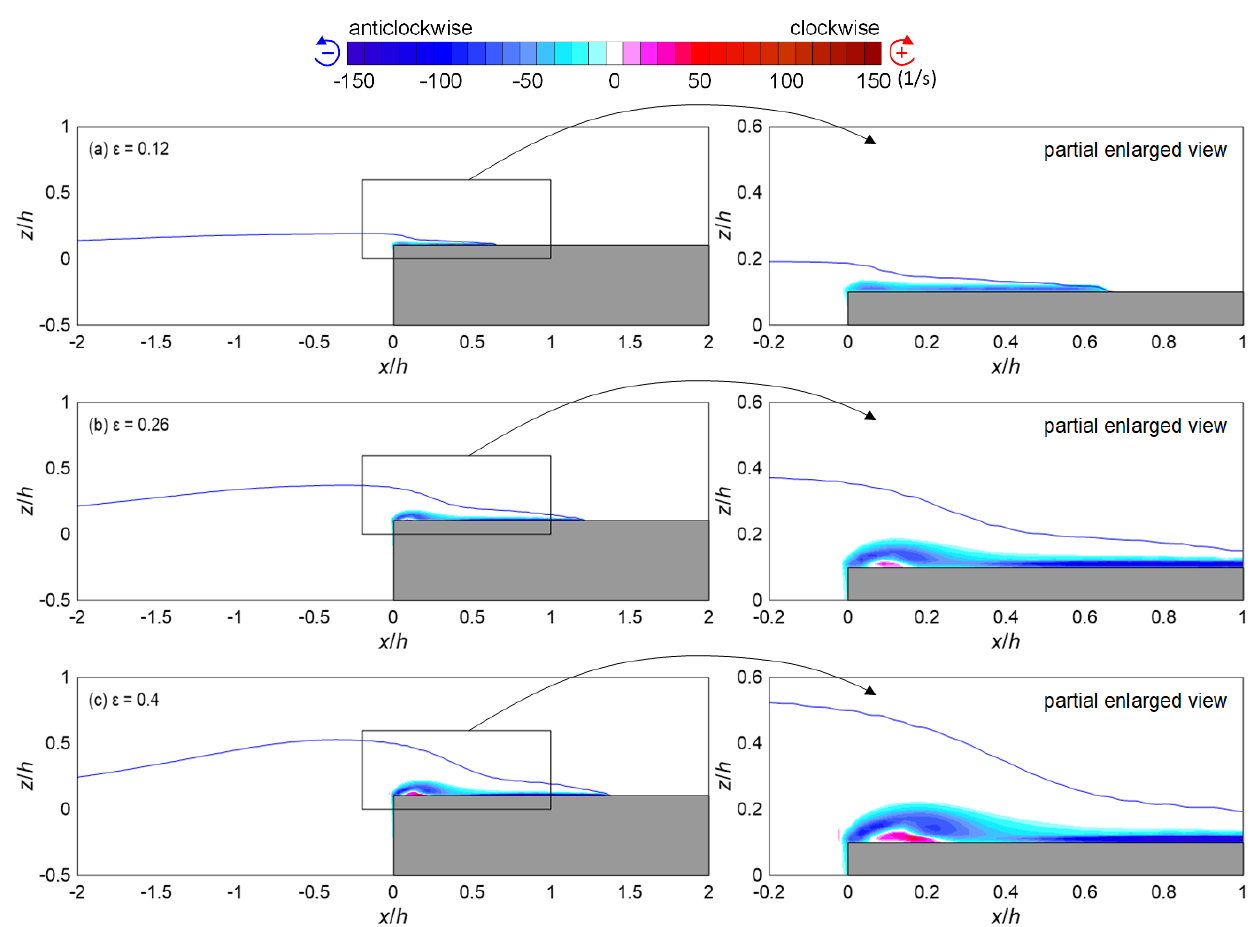
Figure 22. Wave and vortex fields around the VR when the maximum water level occurs at the front of the vertical wall ( 𝑥/ℎ = 0 ).